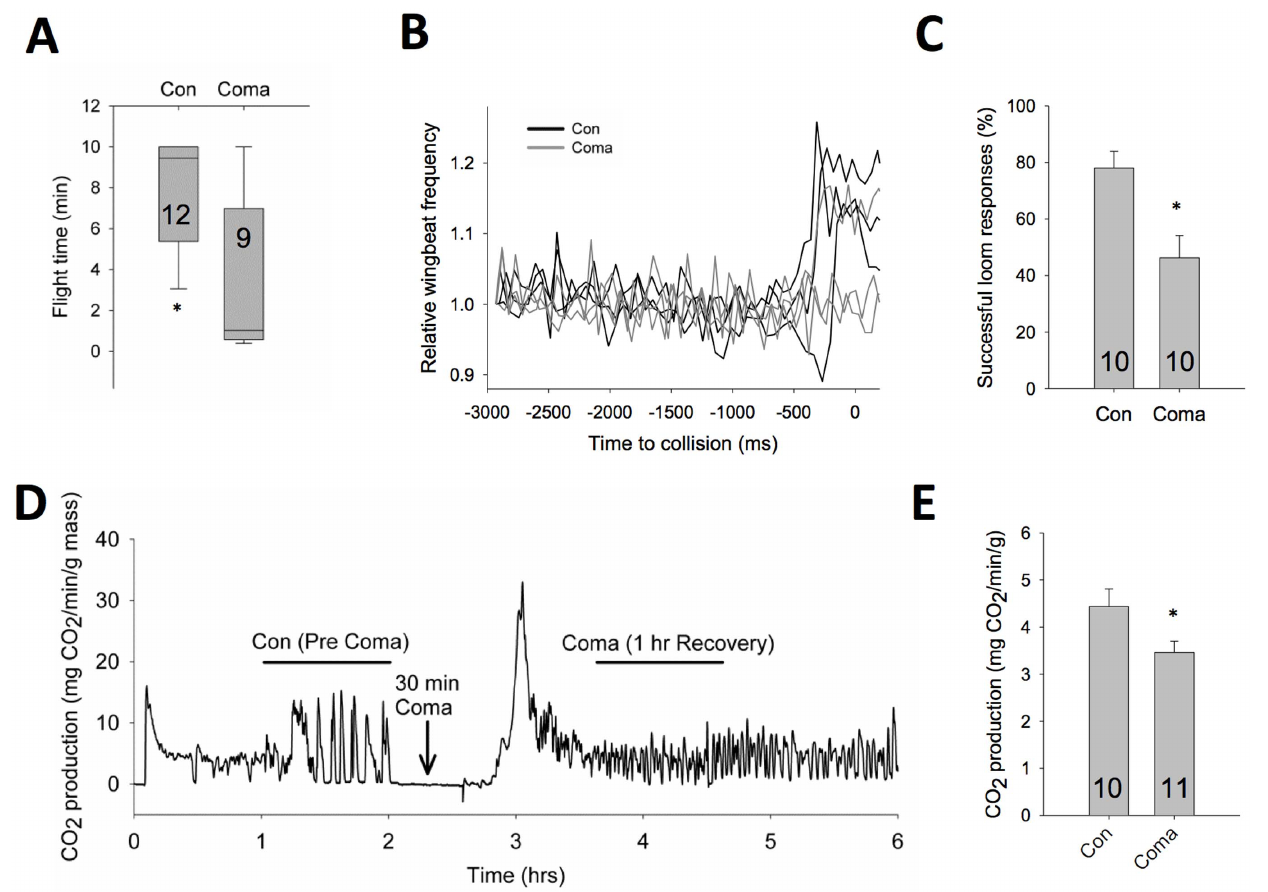
Figure 3. Effect of coma on flight behaviour and basal metabolic rate. ( A ). Coma recovered animals have reduced flight duration in the wind tunnel. Box-plot spans 25 th to 75 th percentiles, error bars represent 10 th to 90 th percentile, with solid line as median value. ( B ). Change in wingbeat frequency as measured through EMG activity from thoracic flight muscles during flight in a wind tunnel. Representative data showing deviations from normal wingbeat frequency for three looms trials in each of a control (black) and a coma-recovered animal (grey). ( C ). Control animals respond more frequently to the target approach than coma recovered animals. ( D ). Individual measurement of whole animal metabolic rate using CO2 respirometry prior to anoxic coma and in the recovery period. Basal metabolic rate is initially increased sharply upon return to normoxia, but is then decreased in the following recovery period. Note that prior to coma this animal displayed discontinuous gas exchange characteristic of quiescent animals. Not all locusts showed this pattern and it did not affect the overall CO 2 measured. ( E ). Metabolic rate is decreased during the post-coma recovery period. Asterisks denote statistical significance (P , 0.05).